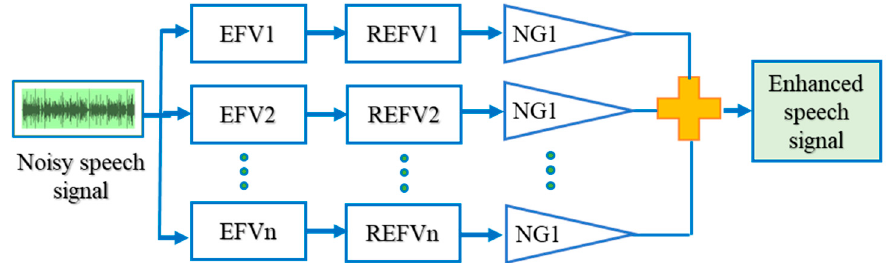
Figure 3. Subspace—based speech enhancement.